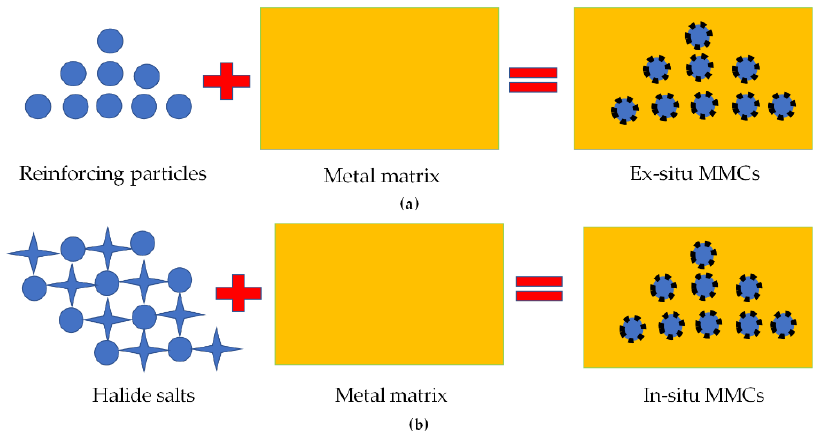
Figure 5. The graphical illustration of MMCs ( a ) ex-situ ( b ) in-situ; based on the data provided in Ref. [22,70].